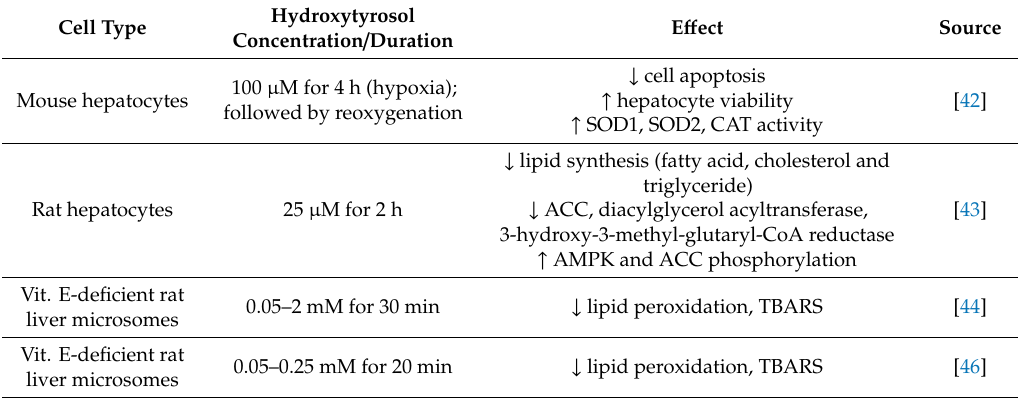
Table 5. E ff ects of hydroxytyrosol on